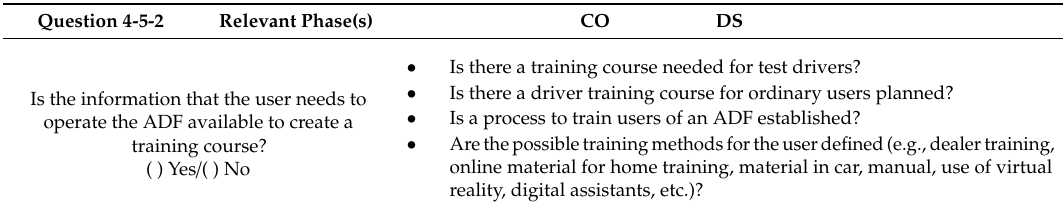
Table 8. Example question Driver Training and Variability of